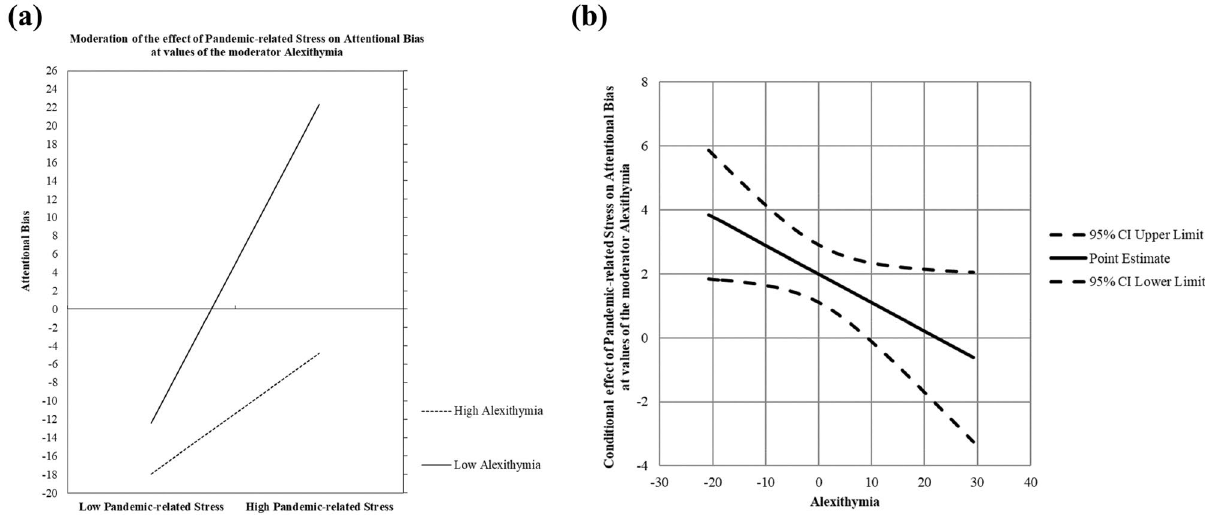
Figure 3. The conditional effect of pandemic-related stress on attentional bias at different levels of